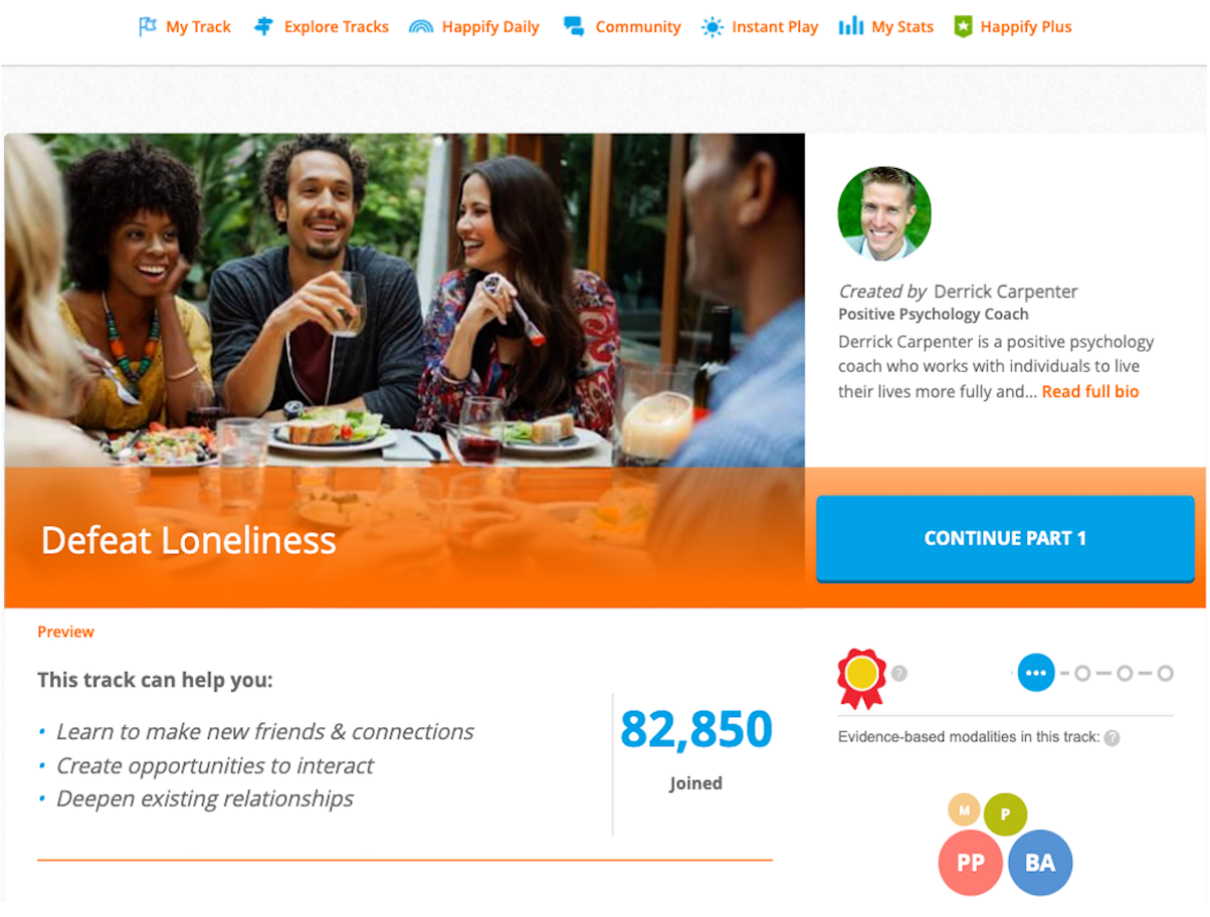
Figure 1. Screenshot of Defeat Loneliness track featured in the pilot randomized controlled